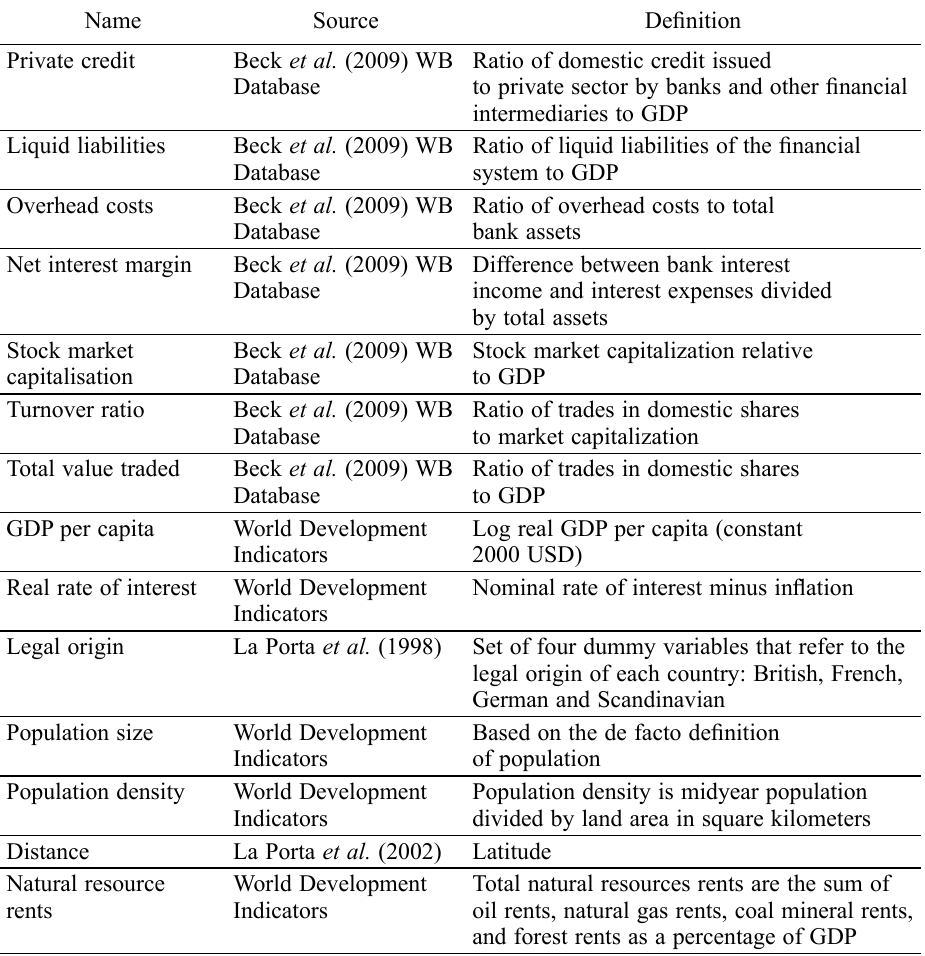
Table 1. Sources of